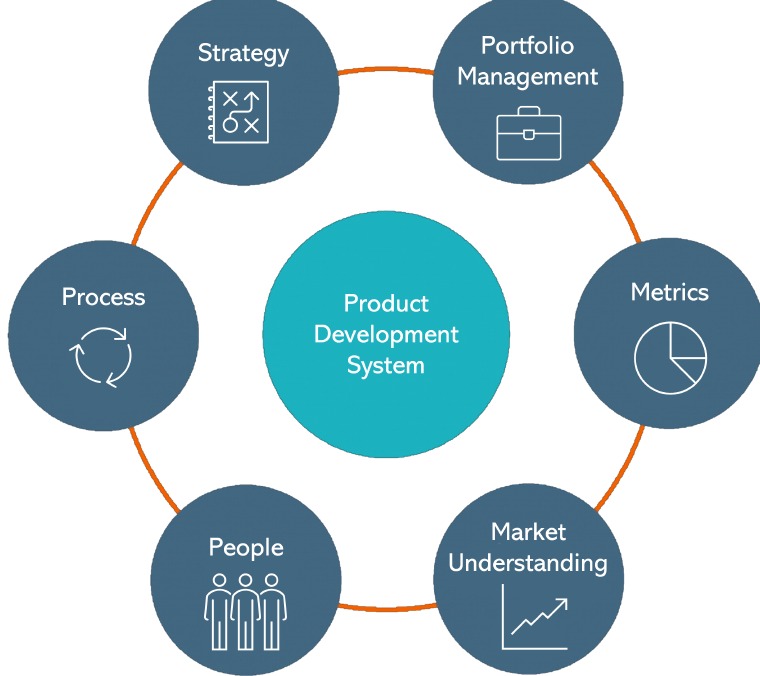
Figure 4. Stages of product